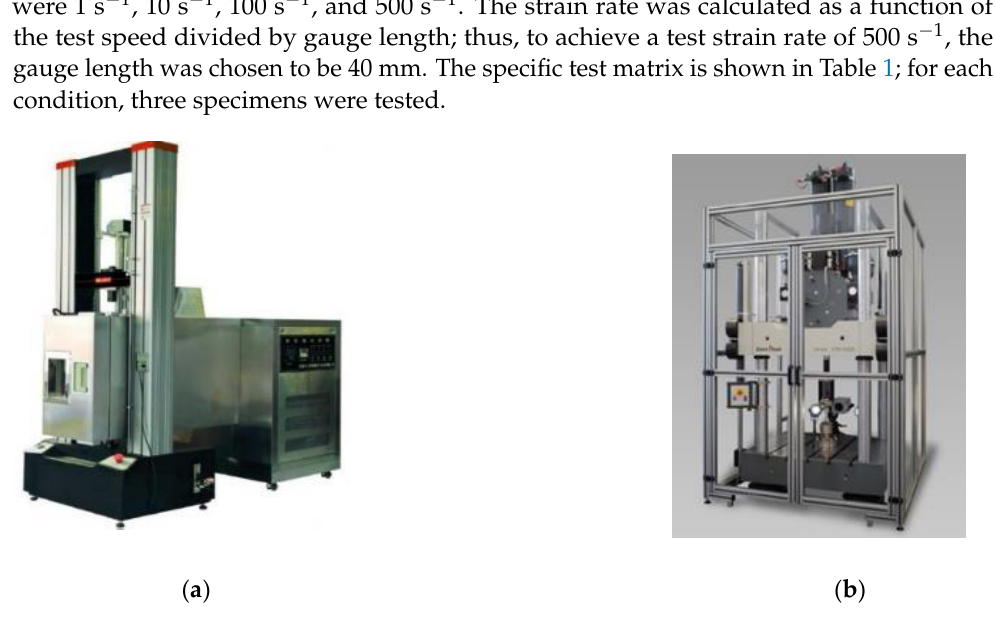
Figure 2. Tensile test machines: ( a ) electronic universal testing machine; ( b ) large dynamic testing machine. Table 1. Tensile test matrix used in this study.